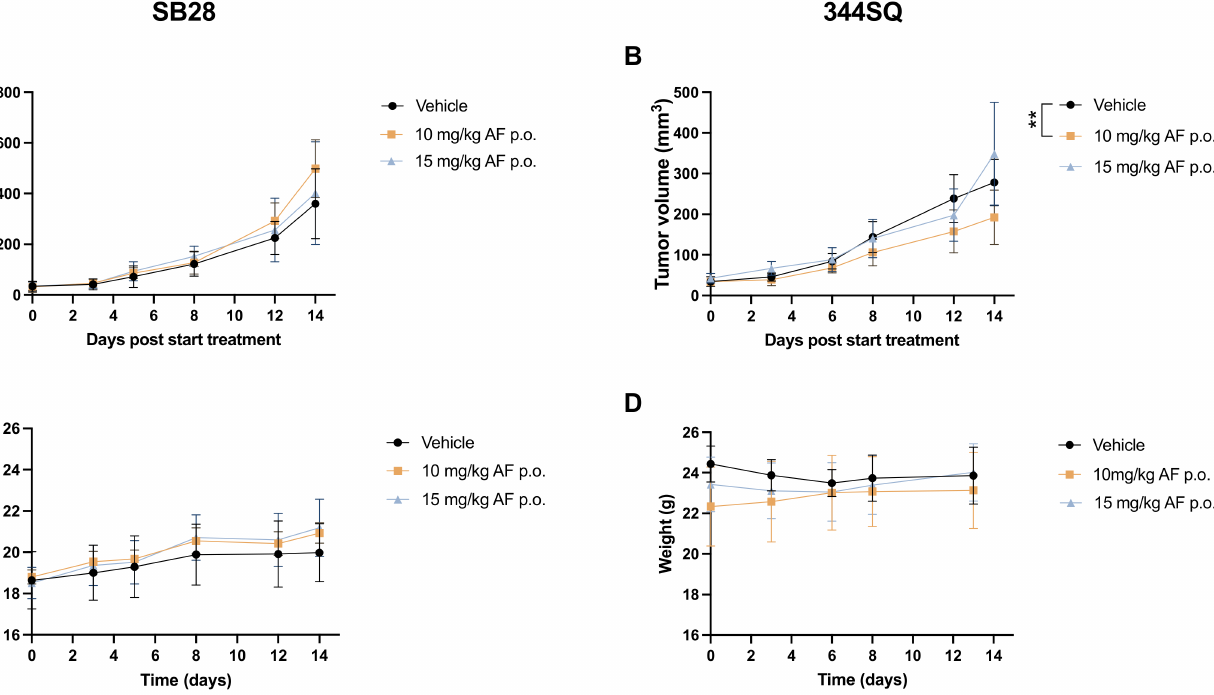
Figure 3. Effect of oral administration of high AF doses on SB28 tumor-bearing C57BL/6J and 344SQ tumor-bearing 129-mice. ( A , B ) Tumor growth kinetics of SB28 ( A ) and 344SQ ( B ) tumor-bearing mice after treatment with high AF doses (10–15 mg/kg) via oral gavage for 14 consecutive days. ( C , D ) Body weight of SB28 ( C ) and 344SQ ( D ) tumor-bearing mice after daily oral treatment with high AF doses (10–15 mg/kg) for a period of 14 days. Data represent mean ± SD. N = 5 mice per group. ** p ≤ 0.01. Compared to i.p. injections and s.c. minipump delivery of AF, oral gavage